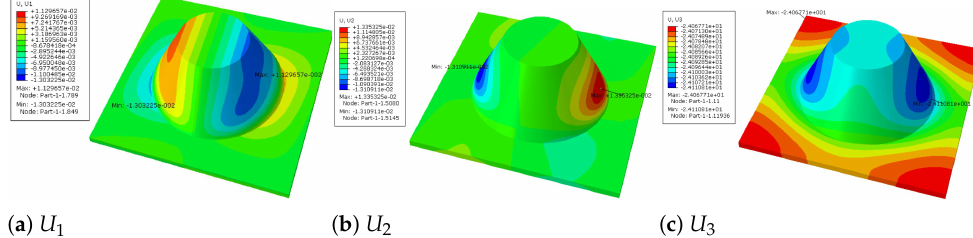
Figure 7. Local displacement distributions within the unit cell closest to the center of the plate in Case 1.